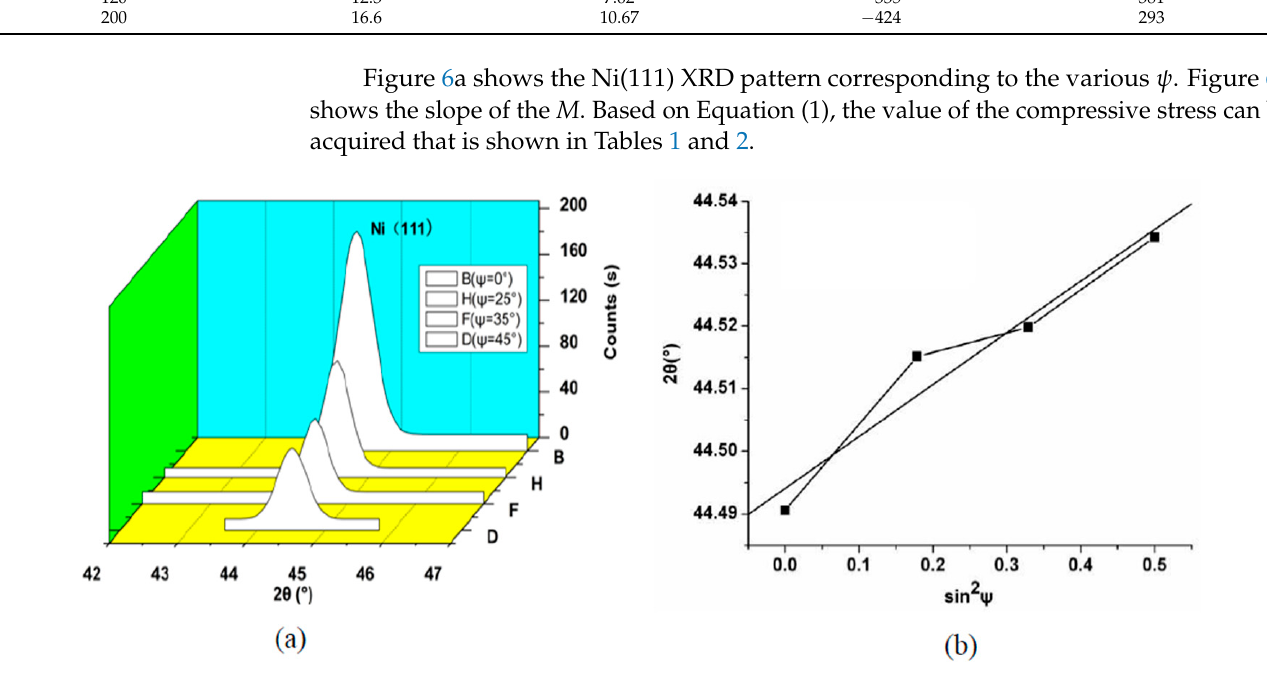
Figure 7. XRD pattern of the electroplated Ni coating: ( a ) 200 W; ( b ) 100 W; ( c ) 0 W; ( d ) 200 kHz; ( e ) 120 kHz; ( f ) 80 kHz. The influences of the ultrasonic activation on the oxygen content of the substrate sur- face are shown in Figure 8. Figure 8a shows that the oxygen content on the substrate sur- face is 19.8% when the ultrasonic power is 0 W. With the increase in the ultrasonic power, the oxygen content on the substrate surface decreased. The oxygen content is 8.5% when the ultrasonic power is 200 W. The oxygen content is reduced by 57% compared with the 0 W condition. Figure 8b shows the changing trend of the oxygen content following with the changing trend in the ultrasonic frequency. With the increase in the ultrasonic fre- quency, the oxygen content increased. The oxygen content is 16.8% under the 200 kHz condition; the oxygen content is 8.2% under the 80 kHz condition. The oxygen content is reduced by 51%. Therefore, the oxygen content on the substrate surface can be reduced by the ultrasonic activation efficiently.